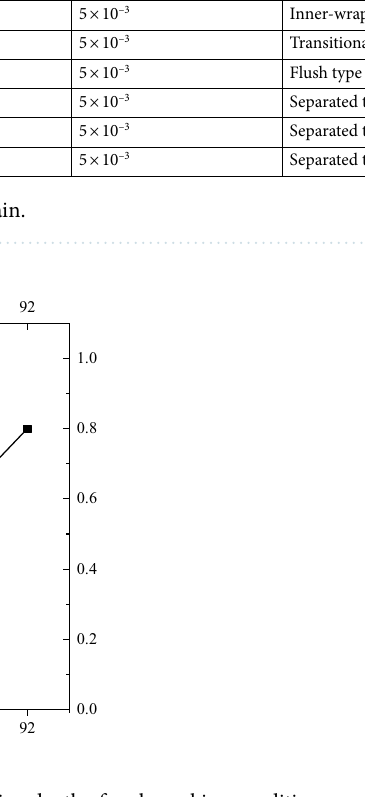
Figure 6. Time chart of the dewatering reaching the design depth of each working